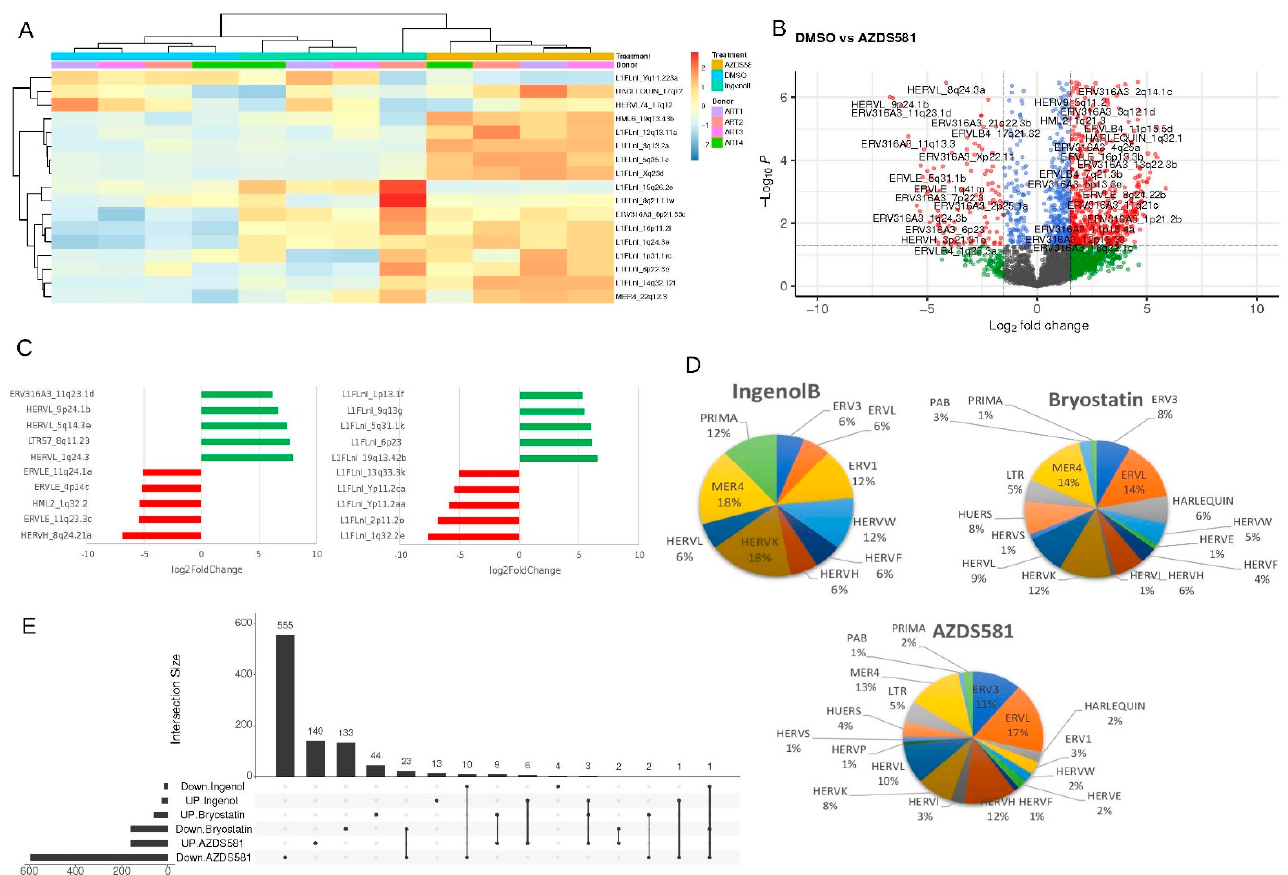
Figure 3. Canonical and noncanonical NF- κ B activation from memory CD4+ T cells. ( A ) Unsuper- vised heatmap of most expressed TE by each LRA treatment (Ingenol B or AZDS581) with relative abundance ≥ 1%. Labels from donors and kind of treatment are also plotted. ( B ) Volcano plot of differential TE expressed by DMSO vs. AZDS581 treatment. Red dots are significantly regulated TE in the AZDS581 treated cells. ( C ) Bar plot of the most differential HERV and L1 expressed showed upregulated (green bar) and downregulated (red bar) TEs by AZDS581 treatment. ( D ) Pie chart shows HERV families regulated in AZD5582, Ingenol B and Bryostatin treatment. ( E ) UpSet plot shows up- and downregulated TEs by each